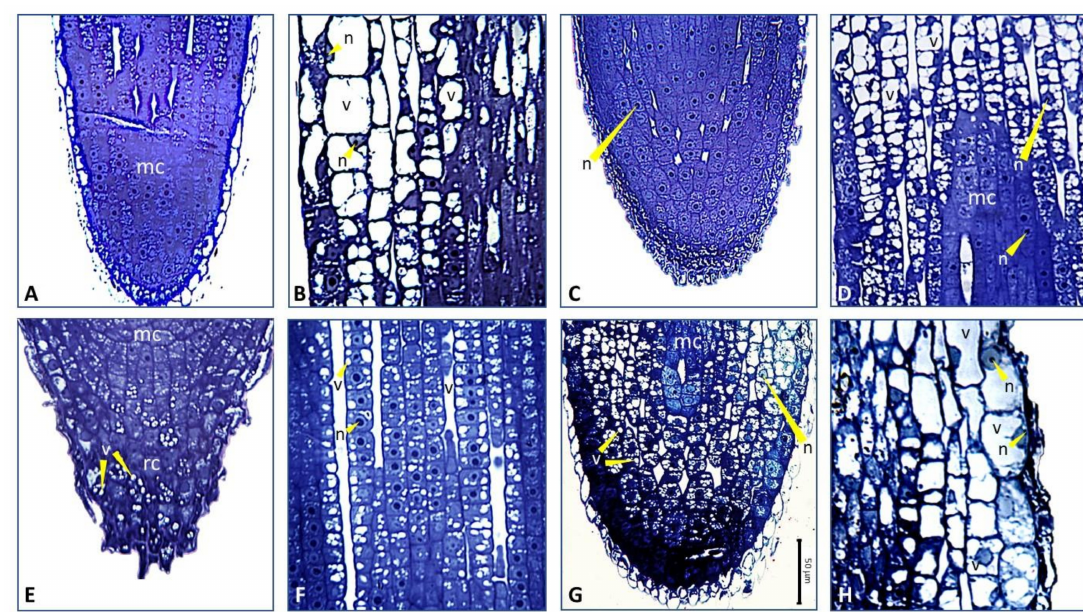
Figure 7. Light micrographs of selected areas of longitudinally sectioned root tips of wild-type (WT) and strigolactone-depleted (SL–) plants grown as in Figures 5 and 6. High magnification images of ( A ) the root apex (mc: meristematic cells) and ( B ) elongation / di ff erentiation zones of WT HP plants (about 100 µ m above the apical meristem); ( C ) the root apex and ( D ) elongation zone (about 200 µ m above the apical meristem) of WT –P plants. Cells have a big central nucleus (n), isodiametric shape, and some are still dividing; ( E ) the root cap (rc) and ( F ) elongation zone (about 200 µ m above the apical meristem) of SL– HP plants. Note the presence of numerous vacuoles (v). The cells show very juvenile characteristics, with large nuclei and numerous small vacuoles scattered in the cytoplasm; ( G ) the root apex of SL– –P plants. Note the small cells enclosing numerous vacuoles in the root cap and below the root apex; ( H ) the area about 100 µ m above the apical meristem in SL– –P plants. Note the transition from cells with several vacuoles to cells bigger in size with one central